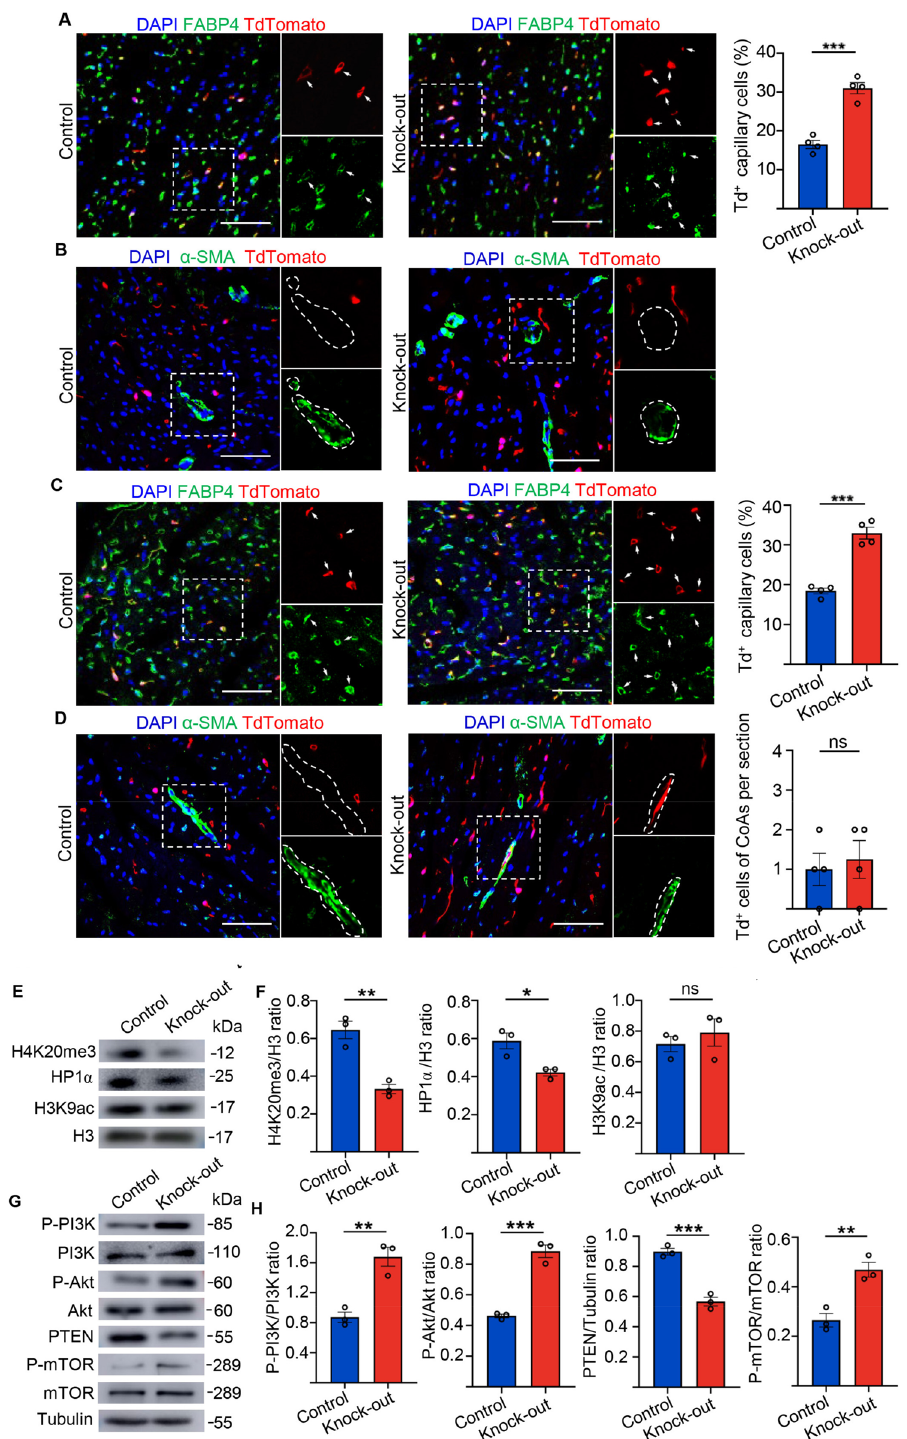
Figure 5. Knock-out of Setd4 contributes to neovascularization of capillaries in adult heart. ( A ) Representative immunofluorescence and quantification for recombinant cells with coronary endothelial cell marker FABP4 in adult mice after four weeks of Setd4 knock-out. n = 4 mice. ( B ) Immunostaining for Td and smooth muscle cell marker of α-SMA shows no Td + coronary arteries generated in adult mice after four weeks of Setd4 knock-out. n = 4 mice. ( C , D ) Immunostaining for Td and FABP4 ( C ) and α-SMA ( D ) and quantification for recombinant cells of capillary and coronary artery potential in neonatal mice after four weeks of Setd4 knock-out. n = 4 mice. Scale bars = 50 μm. Nuclei were stained with DAPI. ( E , F ) Representative western blot analysis ( E ) and relative band densitometric analysis ( F ) of H4K20me3, HP1α and H3K9ac. n = 3. ( G ) Representative western blot analysis of PI3K, Akt, mTOR with their phosphorylated forms and PTEN. ( H ) The relative band densitometric analysis of P-PI3K, P-Akt, P-mTOR and PTEN. n = 3. All data are represented as mean ± SEM. n = 4 mice. Comparison of independent variables was conducted by two-tailed unpaired Student’s t test. *** p <